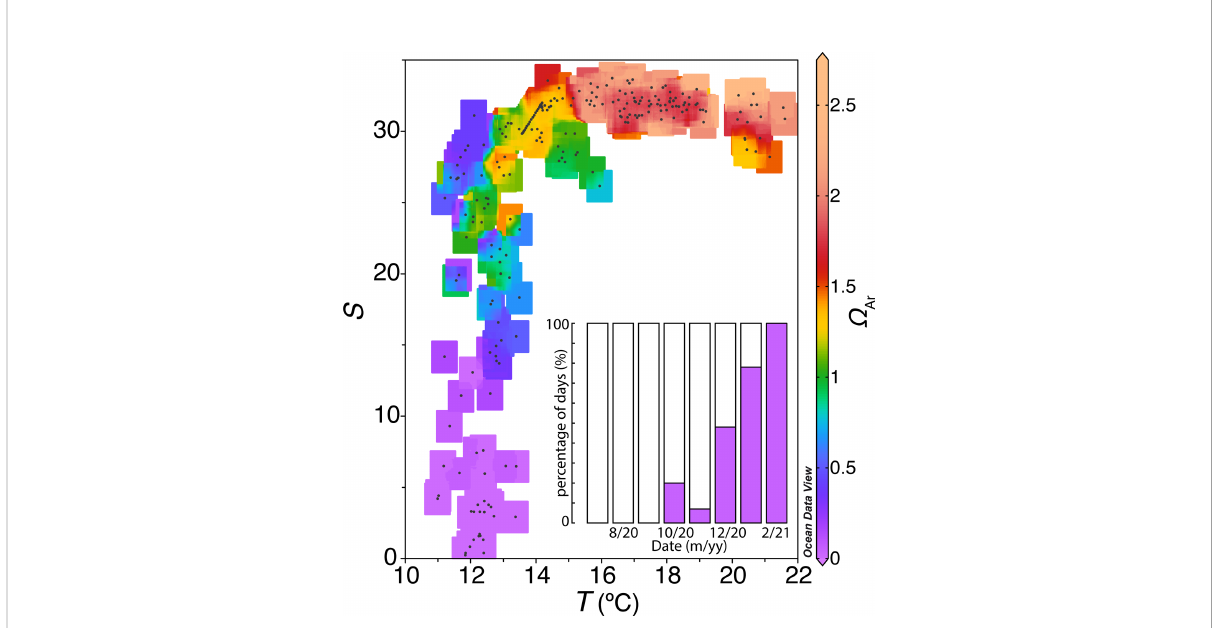
FIGURE 9 Daily averages of salinity versus temperature with colors indicating aragonite saturation status and the percentage of days with aragonite unsaturated water for each month (purple